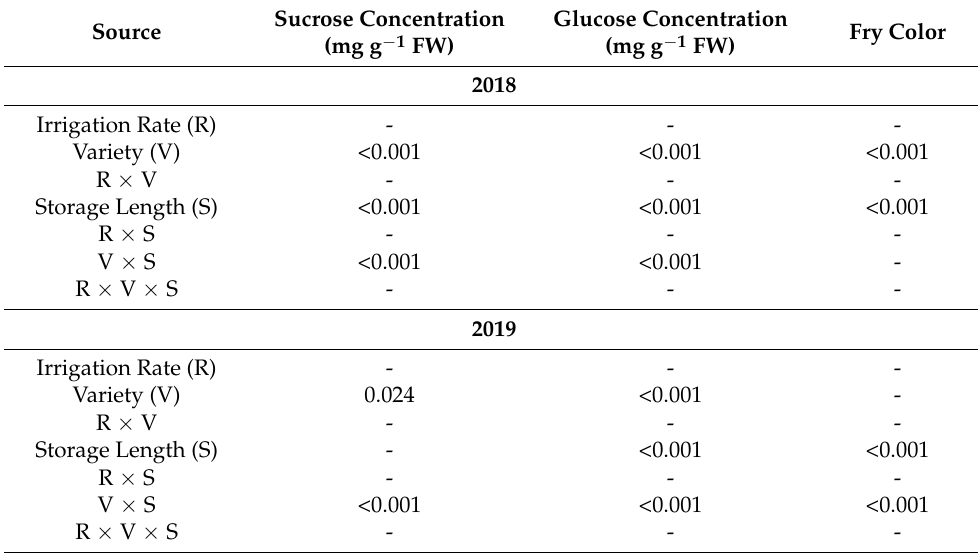
Table 7. ANOVA results of sucrose, glucose and chip fry color for 2018 and 2019 separately. Values that were not significant at α = 0.05 are indicated as ‘-’.